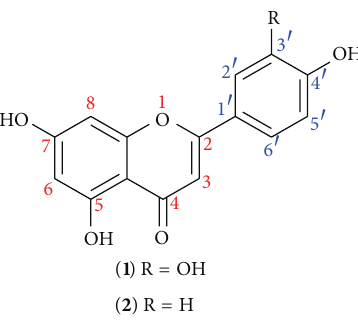
Figure 4: Chemical structures of luteolin ( 1 ) and apigenin ( 2